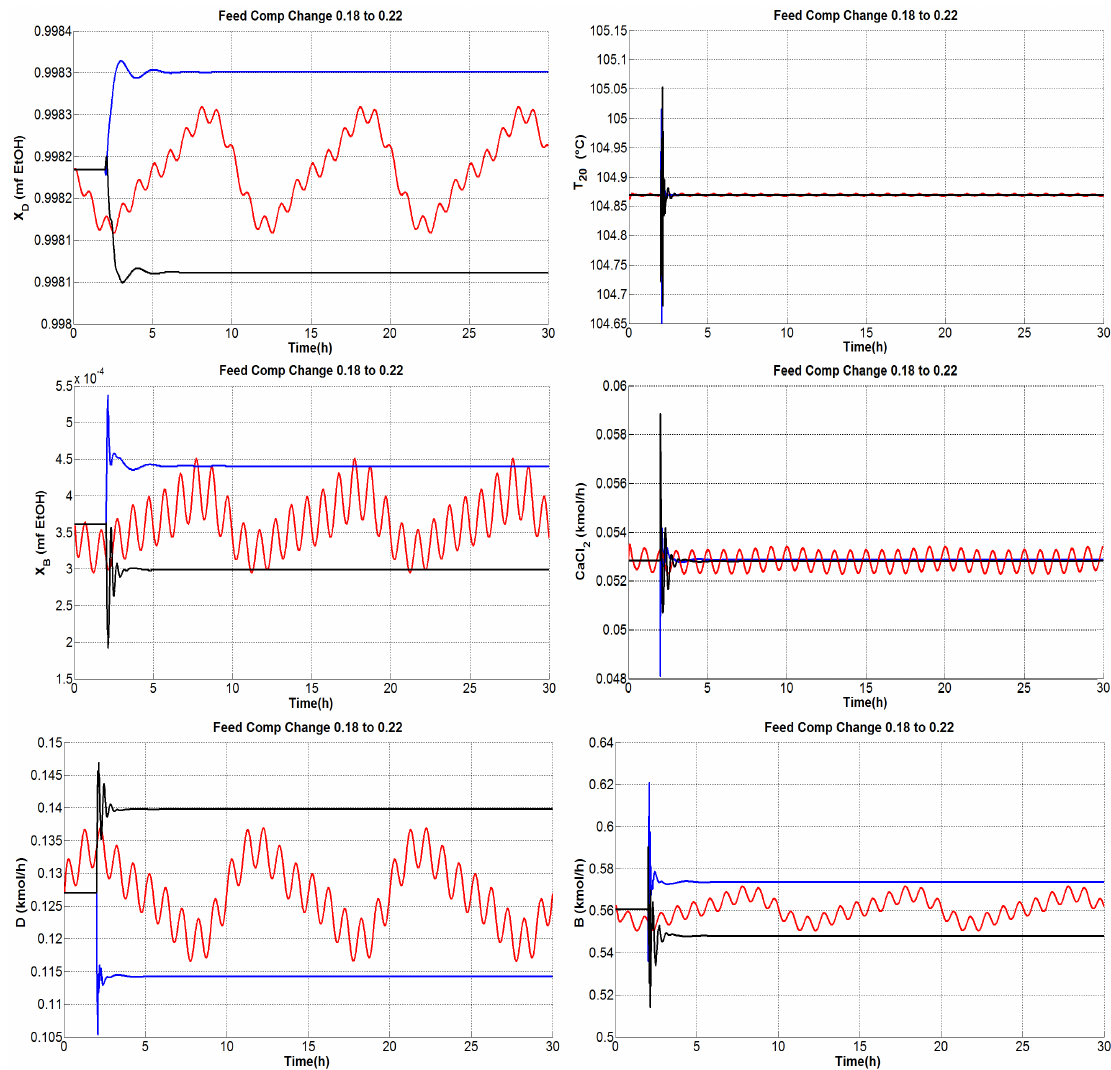
Figure 13. Performance of the RR structure for single-end mode temperature control, assuming step perturbations of the feed molar fraction with amplitude of 10% (black) and − 10% (blue) with respect to the nominal value, and a continuous fluctuating perturbation